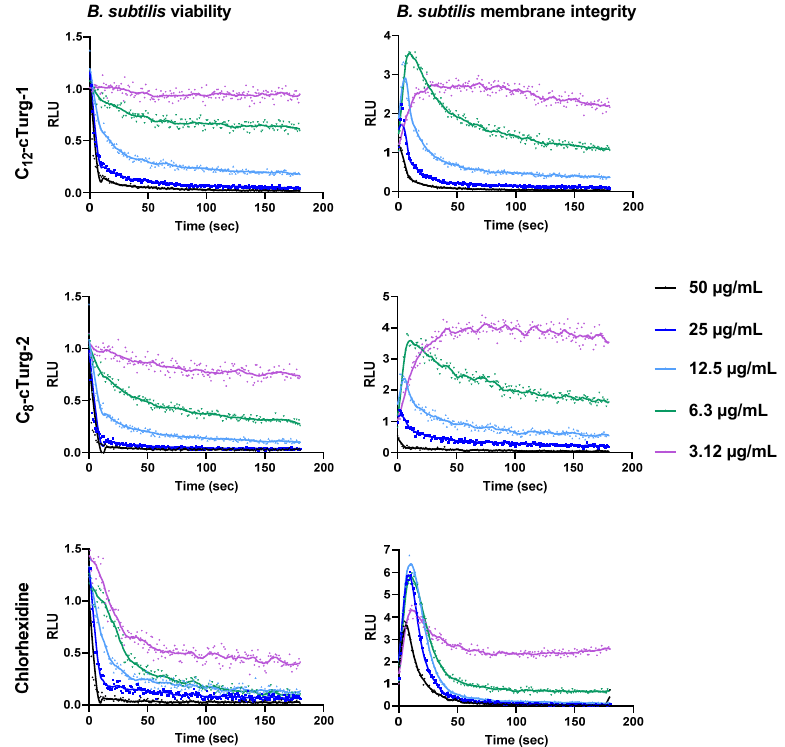
Figure 3. Effects of C 12 -cTurg-1 , C 8 -cTurg-2 and chlorhexidine on the kinetics of viability ( left ) and membrane integrity ( right ) in B. subtilis 168. Light emission normalized to the untreated water control is plotted as relative luminescence emission (RLU) over time (seconds). Kinetics of the immediate effect (within 3 min) on bacterial viability and membrane integrity, as measured by relative luminescence emission in B. subtilis 168 treated with increasing concentrations of the lipopeptides. Chlorhexidine served as a positive (membranolytic) control and water as a negative (untreated) control. All the graphs of this figure show a representative data set where each experiment was run at least three times